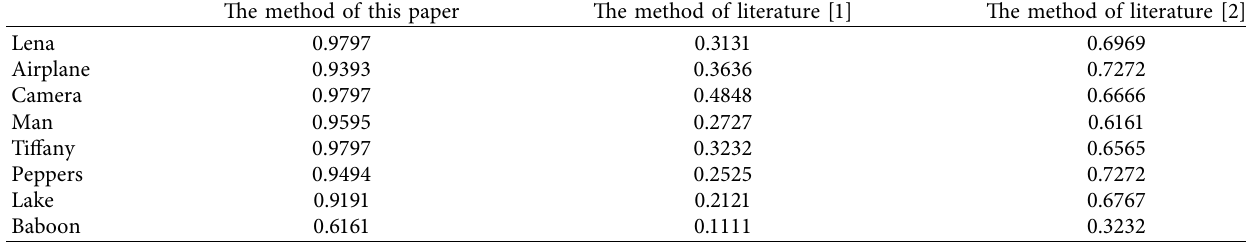
Table 1: Effectevaluation of the digital image reversible information hiding method based on the pixel combination algorithm. The method of this paper